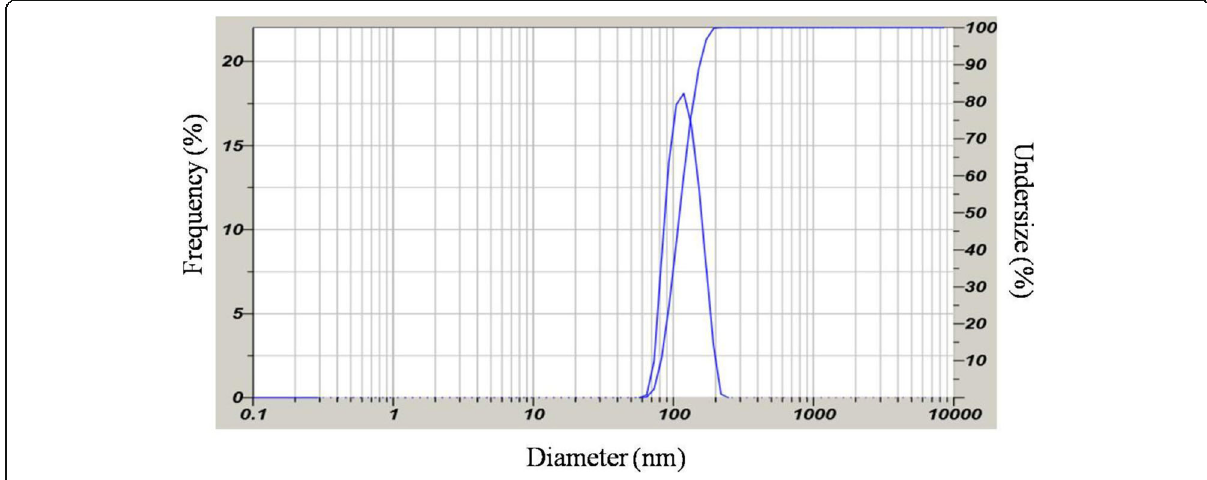
Fig. 6 DLS Analysis of biosynthesised selenium